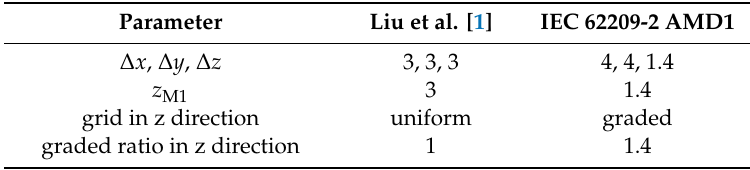
Figure 1. Peak 1-gram average SAR (blue) and 10-gram average SAR (black) of the eleven source antennas normalized to a target peak 1-gram average SAR of 1 W/kg. Probe scanning results are shown for linear (square markers) and spline (circle markers) methods of interpolation and extrapolation. ( a ) Results presented in Liu et al. [1]. ( b ) Results applying standard conformal grid parameters with DASY6 V6.4 [7] or later. Liu et al. [1] greatly overestimated the error of probe-scanning systems to be as much as 40 %. Actual errors are less than 3%. Table 1. Zoom scan parameters stated by Liu et al. [1,4] versus state-of-the-art parameters expected from applying IEC 62209-2 AMD1 for antenna 7. The IEC 62209-2 AMD1 parameters are implemented in DASY6 using the EX3DV4 electric field probe [7].